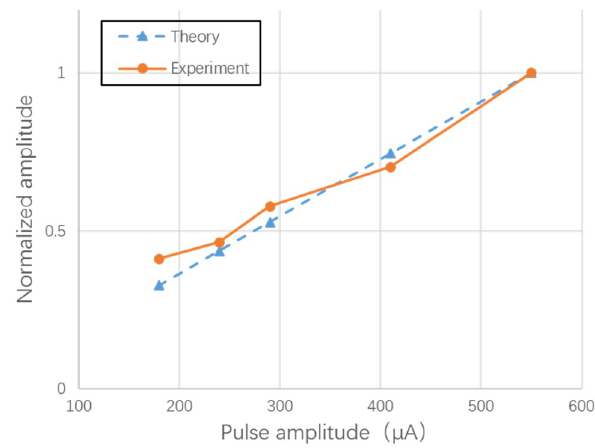
Figure 14. Theoretical calculated and experimentally tested “relationship between Trichel pulse amplitude and radiation signal amplitude”.